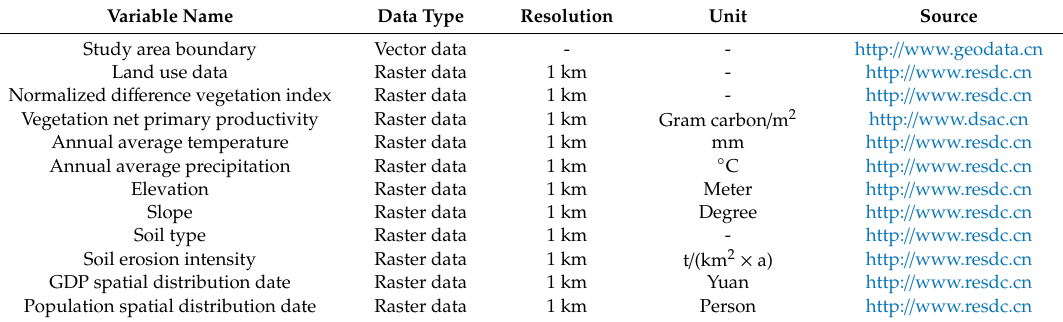
Table 1. Environmental and socio-economic variables used in the